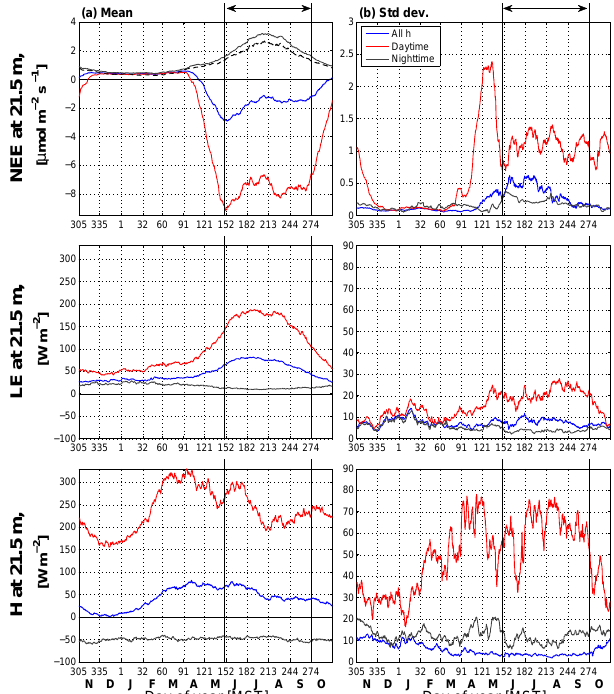
Figure 2. Fourteen-year (a) mean and (b) interannual standard de- viation ( n = 14years) of (top) CO 2 net ecosystem exchange NEE, (middle) latent heat flux LE, and (bottom) sensible heat flux H . To remove the effects of short-term changes due to weather each 30min yearly time series is averaged with a 20-day mean sliding window. In all panels, the statistics are calculated for all hours, day- time (10:00–14:00MST), and nighttime (00:00–04:00MST) peri- ods following the legend in (b) . In (a) , nocturnal NEE calculated without the u ∗ filter is shown as a dashed line. These data were collected between 1 November 1998 and 31 October 2012. Vertical lines with the arrows indicate the average warm-season period used for our